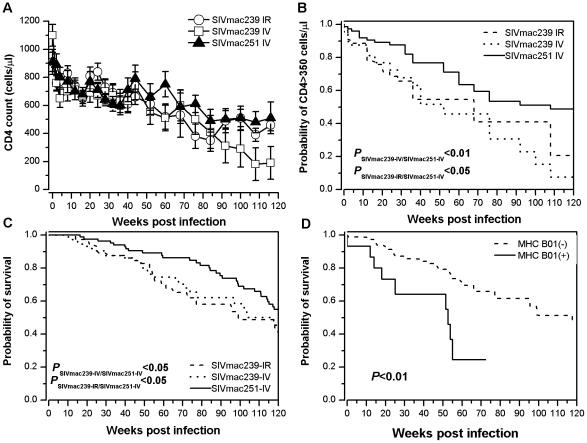
CD4+ T-cell counts and animal survivals in Ch RhMs randomly challenged with pathogenic SIVmac239 (ir or iv) or SIVmac251 (iv).(A) Evolution of CD4+ T-cell counts (mean ± SD) following 118 weeks post viral challenge. (B) Kaplan-Meier plot of probability for maintaining a stable CD4+ T-cell count following 118 weeks post viral challenge. (C) Kaplan-Meier plot of survival probability of Ch RhMs following 118 weeks post viral challenge. (D) Survival curve of SIVmac239-infected Ch RhMs with or without MHC-I B01 allele.